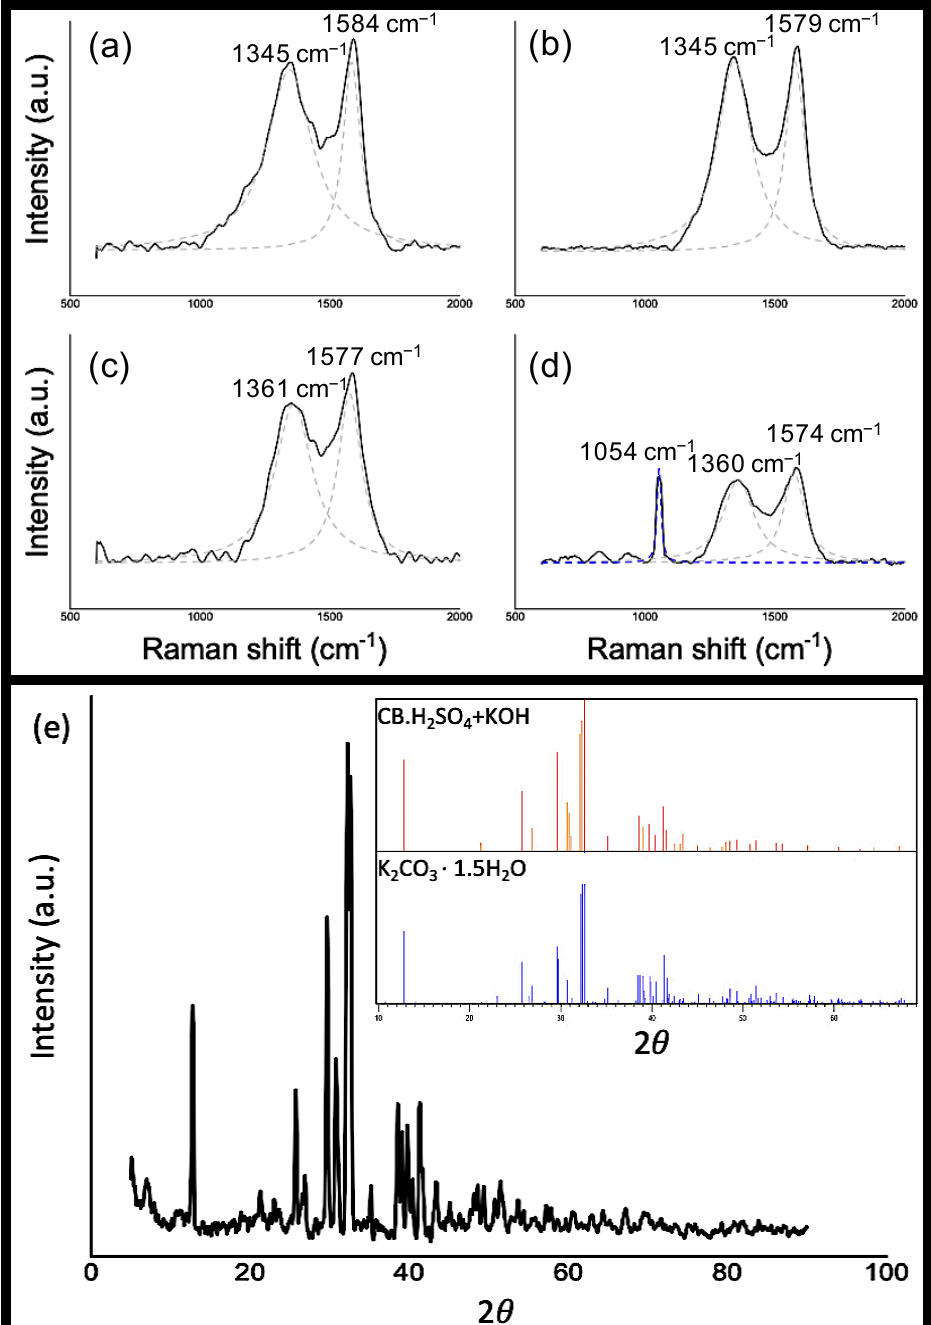
Figure 5. Fitted Raman spectra (black straight line) of ( a ) CB, ( b ) CB.H 2 SO 4 ( c ) CB.KOH and ( d ) CB.H 2 SO 4 + KOH. The D and G bands are plotted in a gray dash line ( a – d ). ( e ) XRD patterns of CB.H 2 SO 4 + KOH inset: X-ray di ff raction (XRD) pattern of the identified K 2 CO 3 · 1.5H 2 O, International Centre for Di ff raction Data (ICDD) Reference code